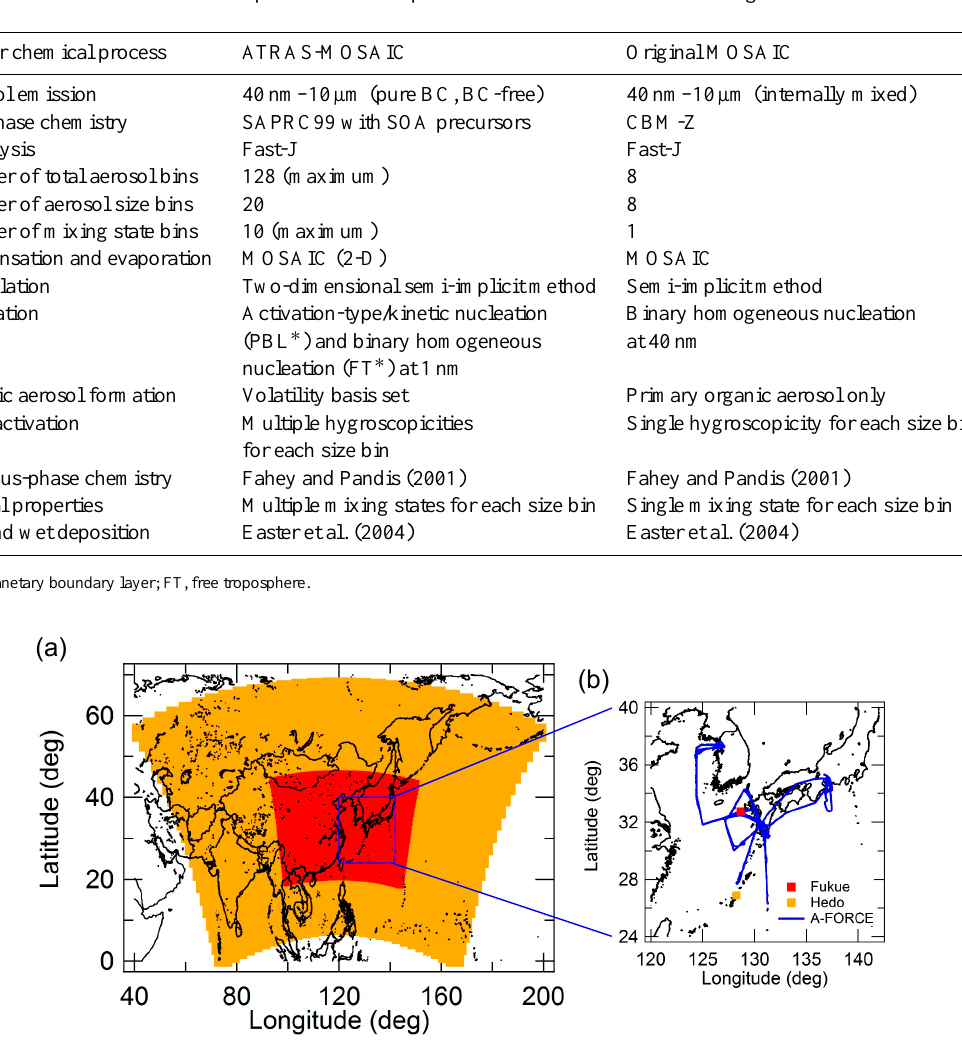
Table 1. Summary of chemical schemes and representations adopted in ATRAS-MOSAIC and the original MOSAIC.